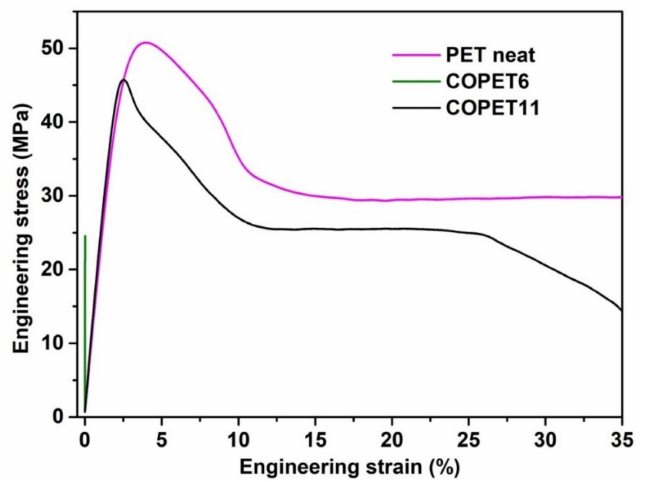
Figure 9. Tensile test of neat PET, COPET6 (SSP without added SA) and COPET11 (SSP with 1% added